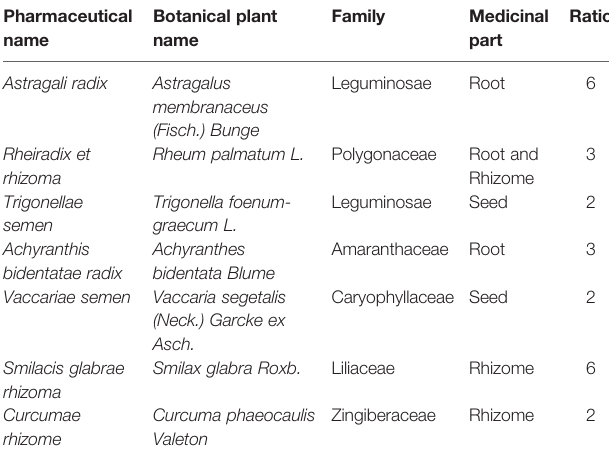
TABLE 1 | Different components of